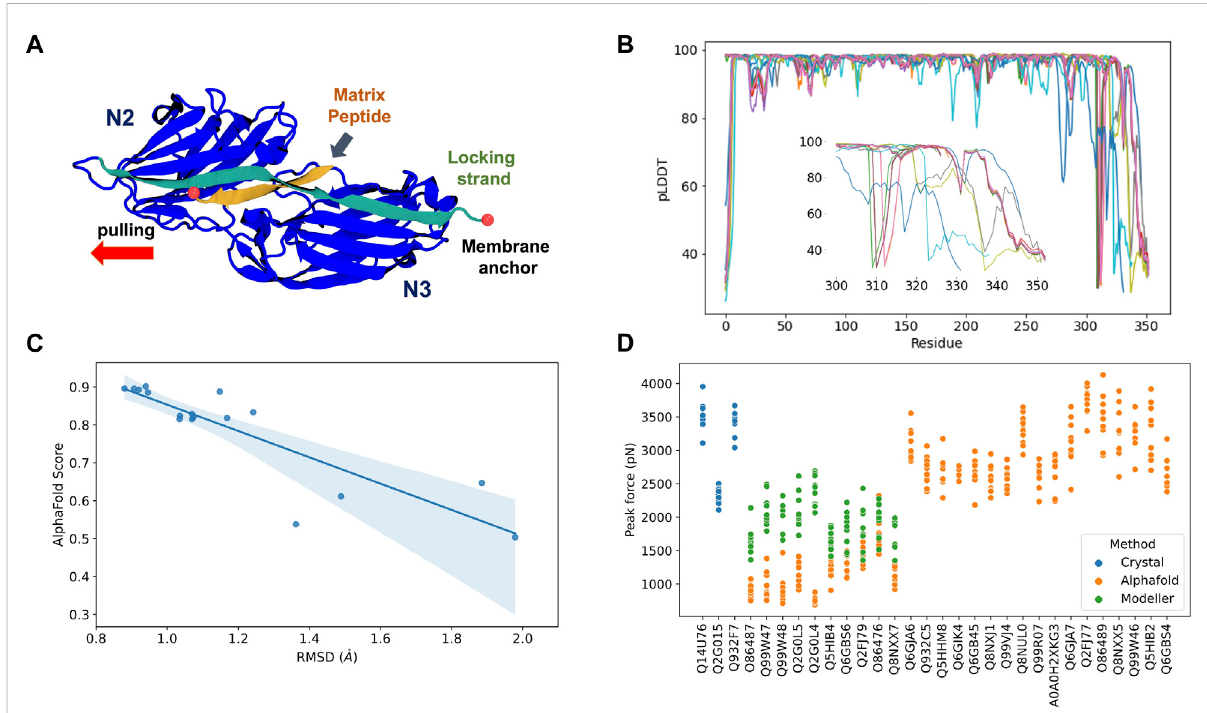
FIGURE 2 AlphaFold Multimer predictions for S. aureus adhesins. (A) Schematic view of adhesin ’ s Ig-like domain. Peptides from the host extracellular matrix are “ locked ” on a cleft between the N-terminal N2 and N3 domains, snugly accommodated by the “ locking strand, ” connecting N3 to N2 by β -Strand complementation(latch).SMDsimulationswereperformedbykeepingtheC-terminal fi xedasitwouldbeanchoredtothemembranewhilethepeptideispulled attheoppositedirectionbyitsN-terminal. (B) ByresiduepLDDTscoresforthetoprankedmodelateachcomplexprediction.Theinsertshowsthevariation among the C-terminal residues. (C) Comparison between AlphaFold Multimer score (ipTM) and RMSD values for equilibration pre-SMD simulations. (D) Peak Forces registered during SMD simulations for each studied complex. Color code indicates the origin of the departure structure: AlphaFold (orange), Modeller (green), or crystallographic (blue). Description of each accession entry are available at Supplementary Table